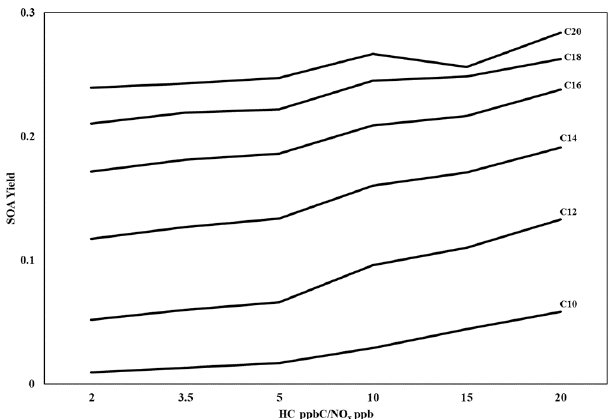
Figure 6. Simulated SOA yields for a series of linear alkanes at six different HC / NO x conditions using the IVC-based product distri- butions. OM 0 = 5µgm − 3 , 298K, RH =